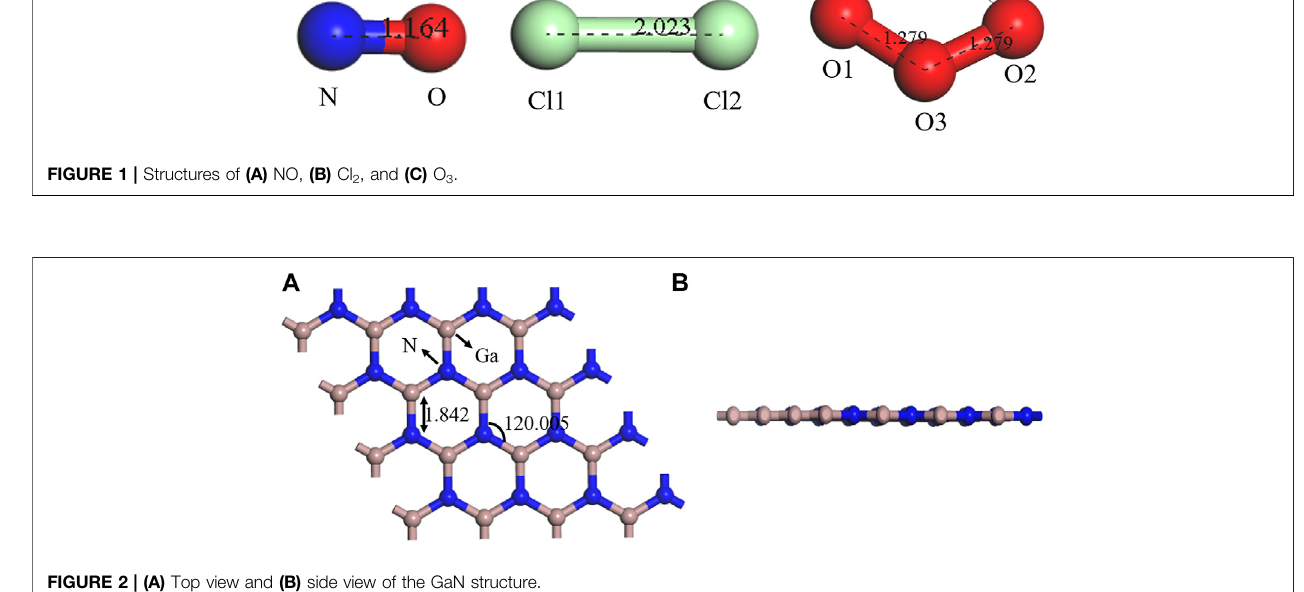
FIGURE 2 | (A) Top view and (B) side view of the GaN structure.